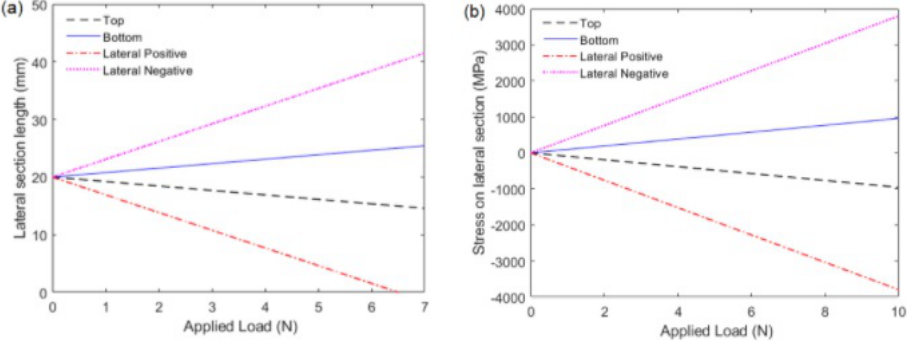
Figure 2. Stress and strain effects on optical fiber under bending. ( a ) Stress on the lateral section positioned on the top, bottom and lateral sides of the fiber as a function of the applied load. ( b ) The final longitudinal length of the lateral section positioned on the top, bottom and lateral sides of the fiber as function of the applied load.